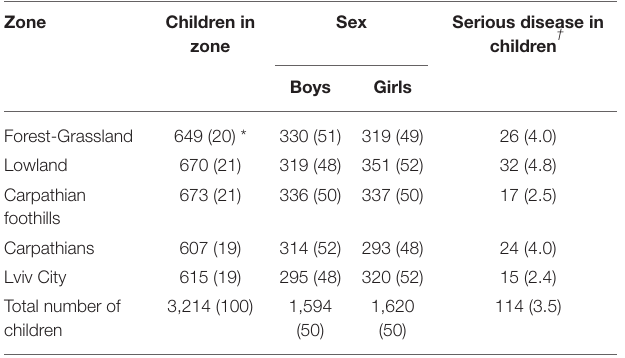
TABLE 1 | Sex distribution and presence of serious disease in children among five geographic and climate zones in the Lviv region. Zone